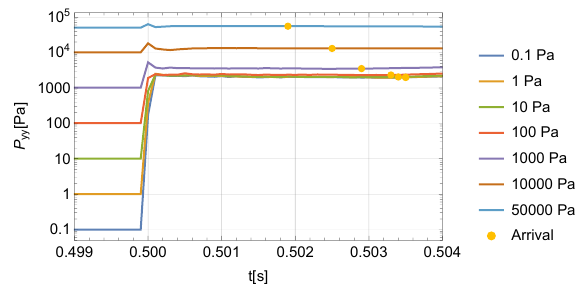
Figure 3. P yy of the particles in the container versus time. Data points were taken 0.005 s before the initiation of the wave. Di ff erent line colour represents a di ff erent overbur- den pressure. The yellow dots show the instant the peak of the wave reached the second slice of particles from the bottom. Cohesionless grains, impact at 0.5 m / s.